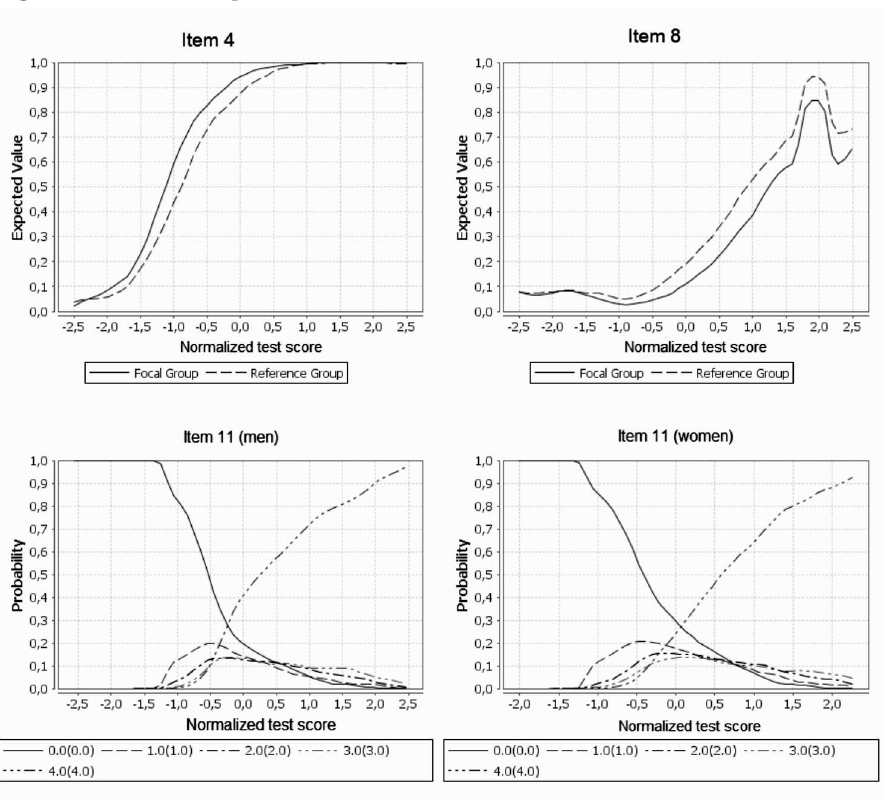
Figure 4.1–4.4. Non-parametric item characteristic curve for DIF